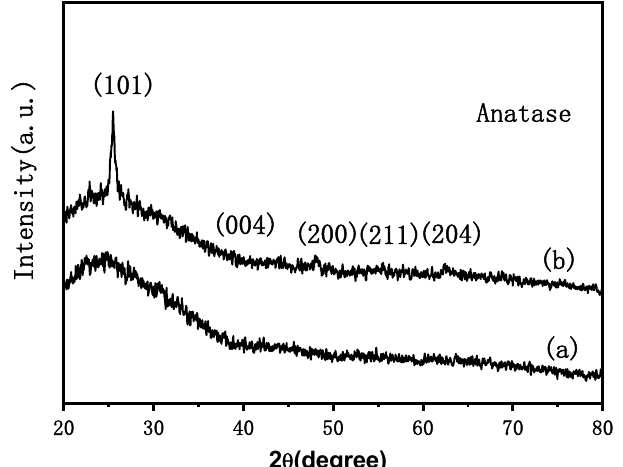
Figure 5. XRD spectra of the web-like TiO 2 thin film: (a) before heat treatment; (b) prepared by pulling seven times.